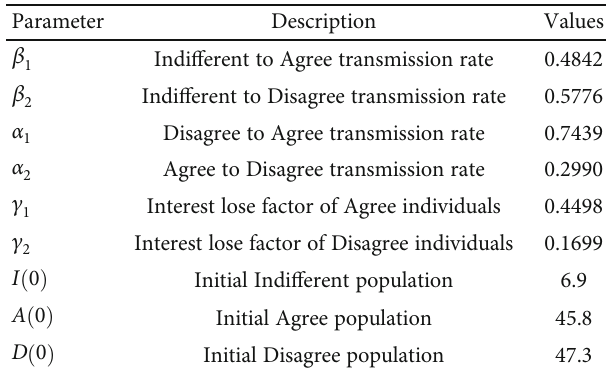
Table 1: Parameter